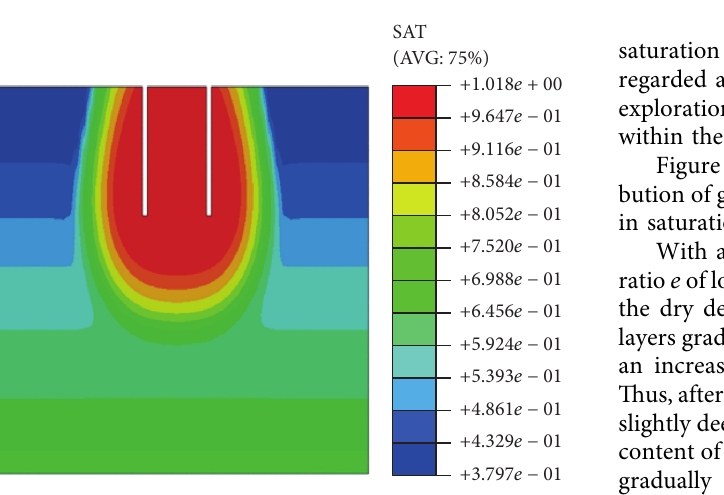
Figure 9: Cloud map of saturation distribution for double water injection